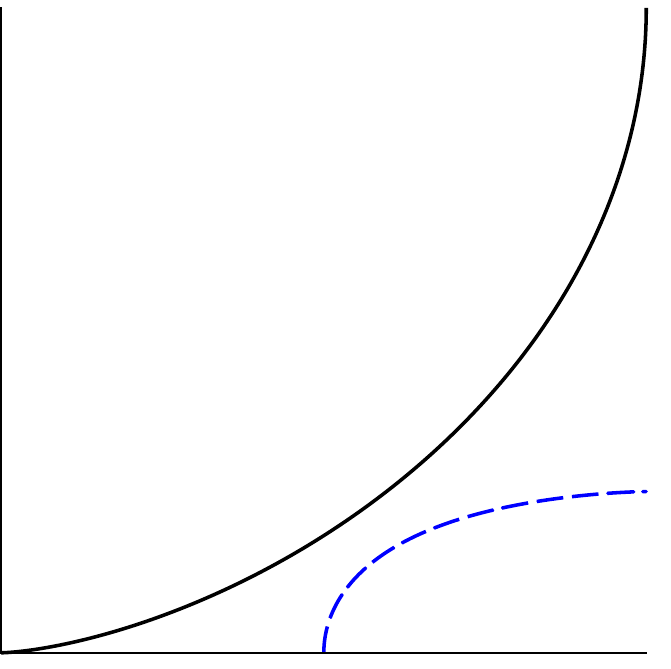
Figure 3. The scale factor a ( t ) for the remaining problems discussed. The curves correspond, respectively, to the brachistochrone problem (black, solid) and the terrestrial brachistochrone problem (blue,